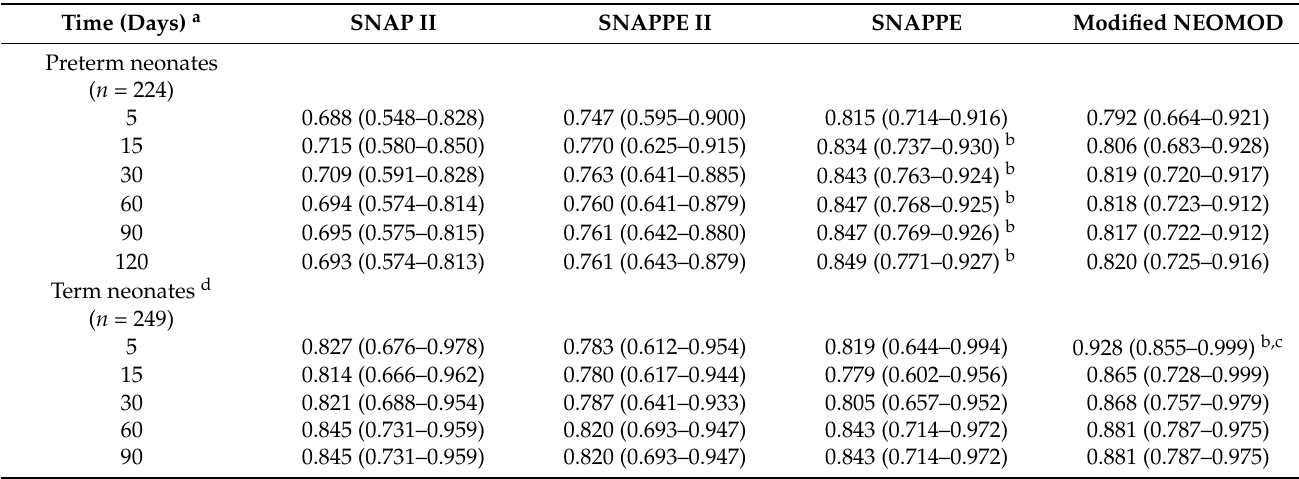
Table 3. Area under the Curve (AUC) showing the prognostic power of mortality indexes for preterm and term infants over time.